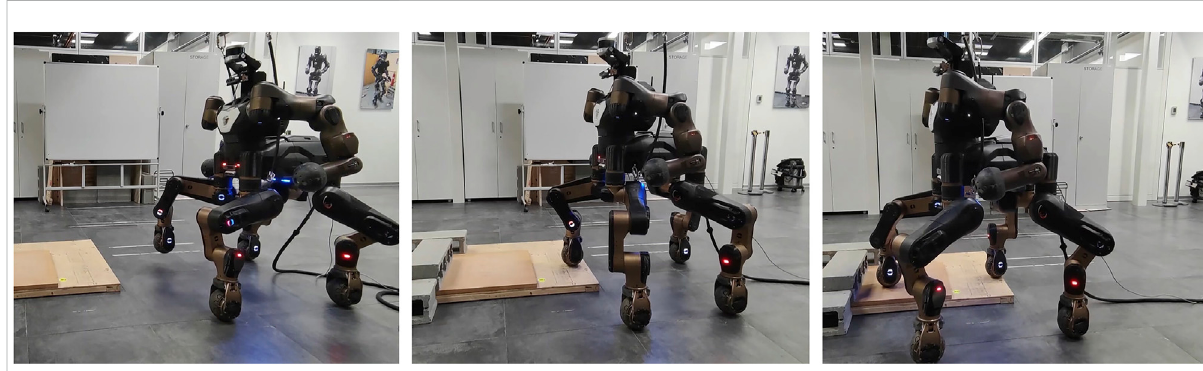
FIGURE 5 Snapshots of the variable stiffness locomotion, where the robot needs to walk up two steps in the workspace without knowing the terrain geometries beforehand.